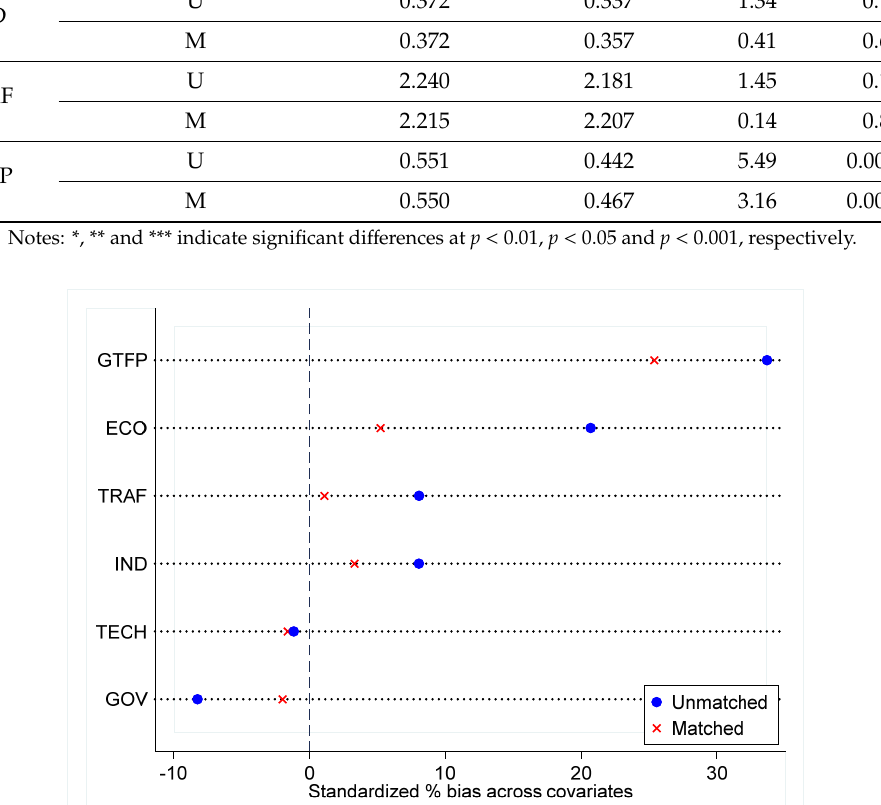
Figure 2. The probability density of the propensity scores. 4.3.2. Changing the Treated Group We now offer a further robustness test using the third batch of smart cities that emerged in 2014 as the new treated group. As before, we implement a regression analysis and obtain some valuable results, as shown in Table 5. After changing the treated group, smart city policies still play a significant role in promoting GTFP.